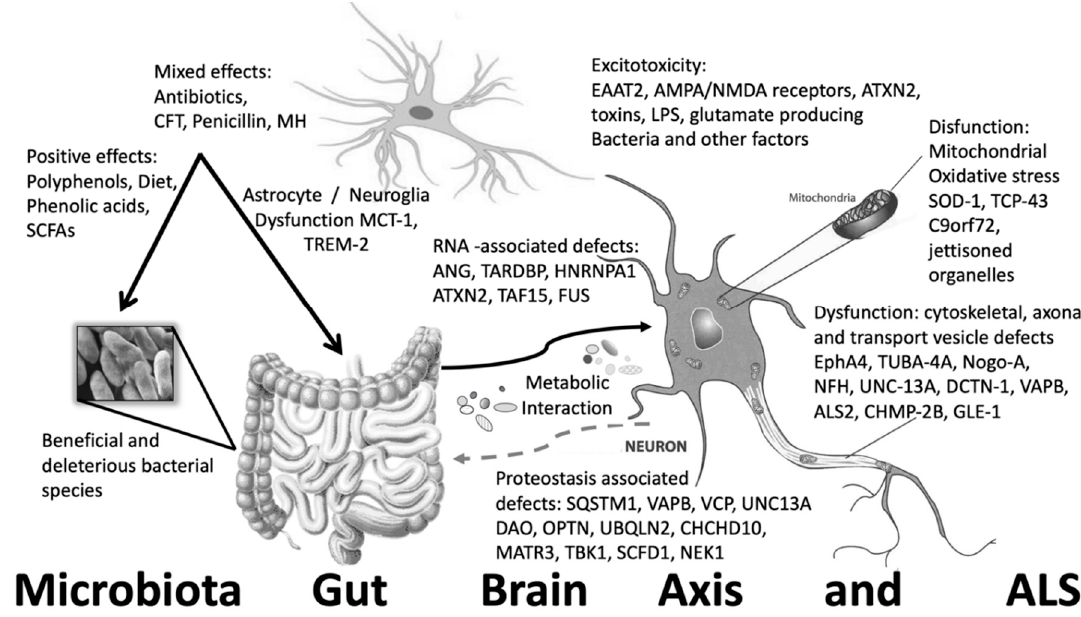
Figure 1. Mechanisms of pathogenesis in amyotrophic lateral sclerosis and neurodegeneration involving key cells, bacteria and systems including genetic, mitochondrial, environmental and epistatic interactions with the gut microbiota and direct bacterial infection mechanisms.